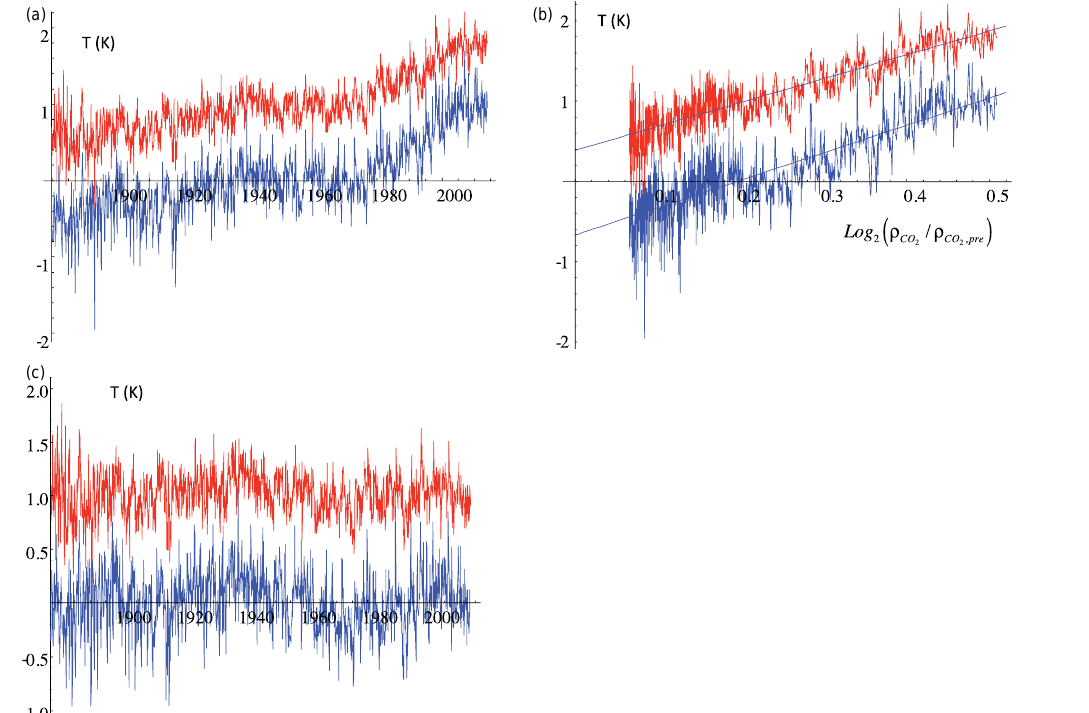
Figure 3. (a) Upper left: the monthly surface temperature anomaly series from NASA GISS data (the monthly d T s series). (b) Top (red) is the global average, displaced upward by 2K for clarity; the bottom (blue) is the Northern Hemisphere series displaced upward by 1K. Upper right: the same as the upper left but for the temperatures as functions of the logarithm of the CO 2 concentration ρ CO normalized by the 2 = 277ppm (global values are displaced upward by 2K and Northern Hemisphere values are displaced by 1K pre-industrial value ρ CO 2 , pre for clarity). The regressions have slopes indicated in Table 2; they are the effective climate sensitivities to CO 2 doubling. (c) Lower left: the residues of the linear regressions of the upper right; the estimate of the natural variability (global – red, top; Northern Hemisphere – blue, bottom) has been shifted upward by 1K for clarity. against the temperature anomalies at monthly and annual Table 2. The climate sensitivities estimated by linear regression of log 2 ρ CO 2 resolutions from global and Northern Hemisphere series. The far right column shows the 20-year lagged sensitivity over 1900–2013, i.e.